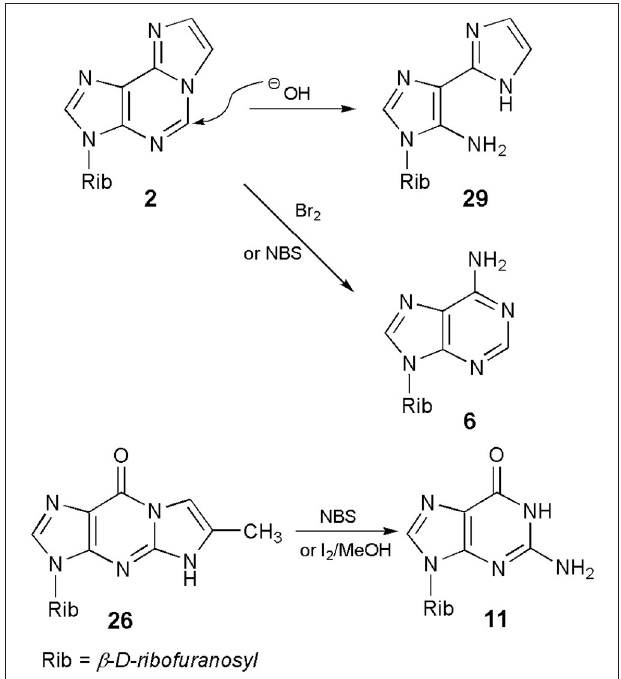
SCHEME 6 | Ring-opening reactions of